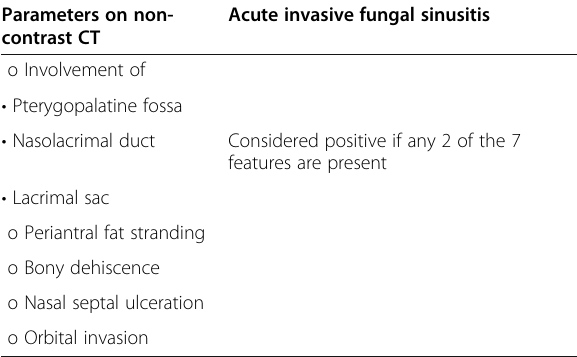
Table 1 The 7 variable CT-based model [12] Parameters on non- Acute invasive fungal contrast CT